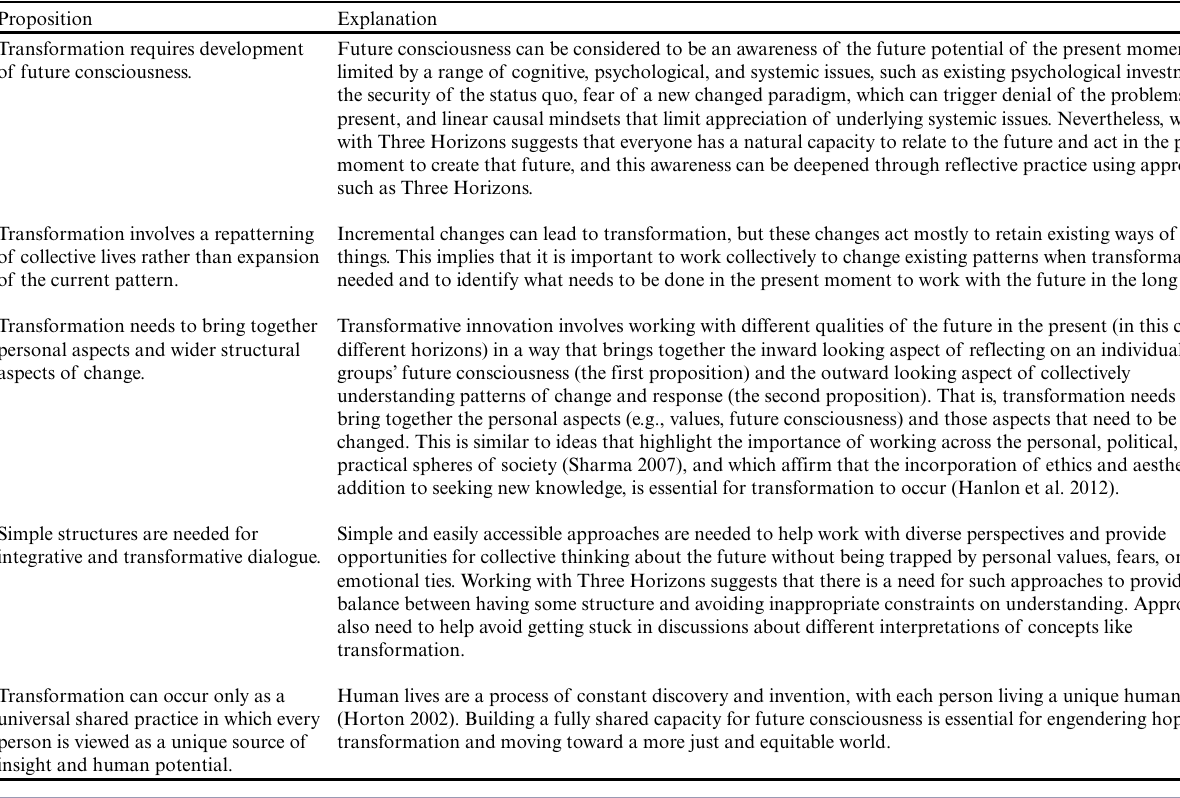
Table 3 . Key propositions about deliberate transformation derived from observations and experience of facilitating the practice of Three Horizons (based on some of the insights in Sharpe 2013).